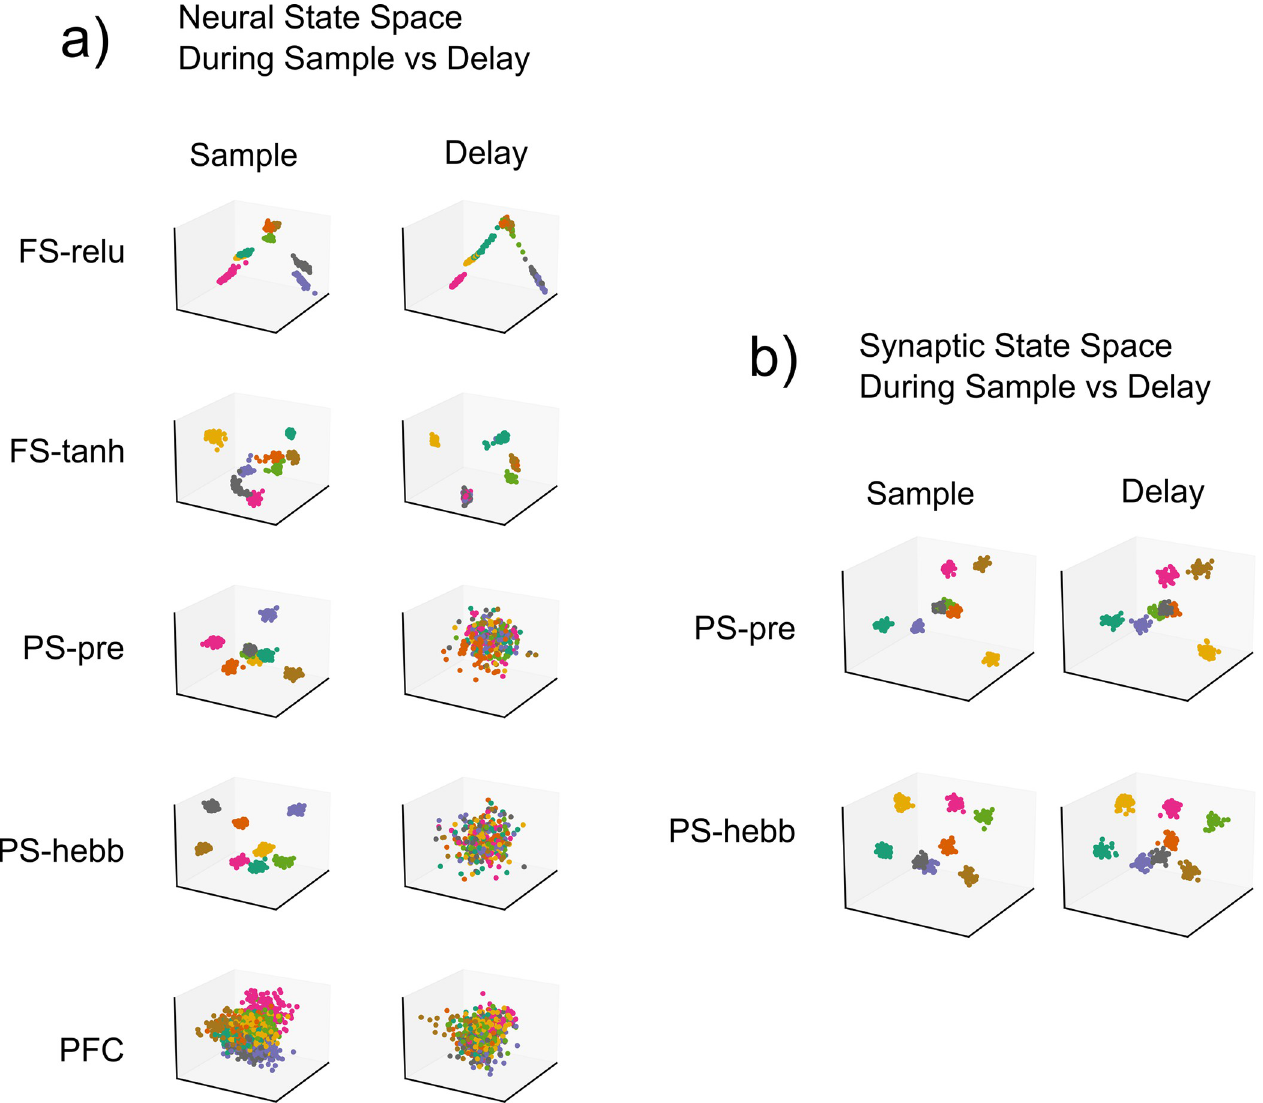
Fig 6. Dimensionality reduced space plots for the most brain-like models. Time-averaged RNN activity during the sample-period as well as 500ms before the end of the delay period. Linear Discriminant Analysis (LDA) was used to project the data into three-dimensions. To account for differences in training/test splits, an Orthogonal Procrustes operation was used to rotationally align the sample and delay period activity. Colors denote sample IDs. Fixed synapse models have activity organized around simple attractors in state space. There is one attractor for each sample ID. Plastic synapse models exhibit high sample- separability in synaptic state space, and limited separability in the neural state space during the delay period. Similarly, PFC exhibited higher neural discriminability during the sample than during the delay period. Comparison between trials with and without a distractor showed that the distractor temporar- ily knocked trajectories out of the attractor state. These trajectories quickly returned to the pre-distractor attractor state. This is how the fixed-synapse RNNs achieve robustness to the distractor. Once the neural trajectories were ‘captured’ by the appropriate attractor, they remained fixed there and can return there after being perturbed. In terms of neural activity this means that the spike rates stayed elevated across the delay period corresponding to the sample identity. In other words, these models achieve robust WM through persistent neural activity as a consequence of attractor dynamics, as observed in many prior models.